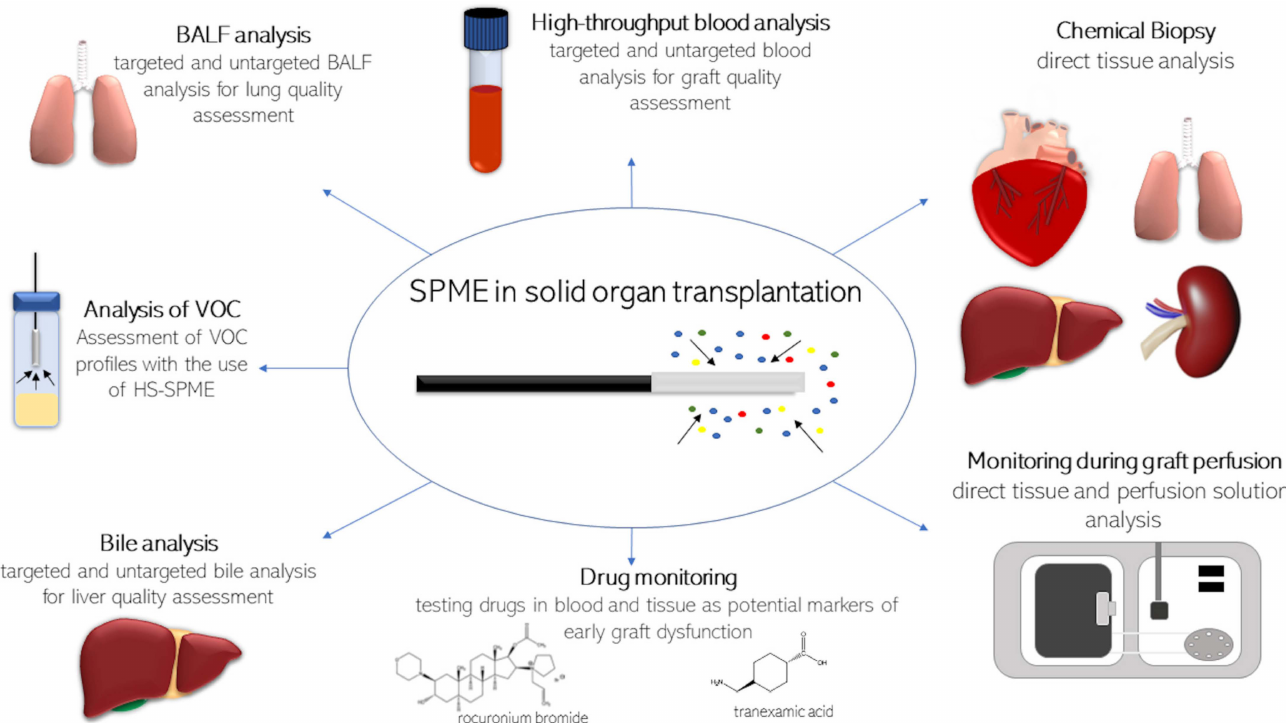
Figure 2. Exemplary application of solid-phase microextraction in solid organ transplantation. Details are discussed in the